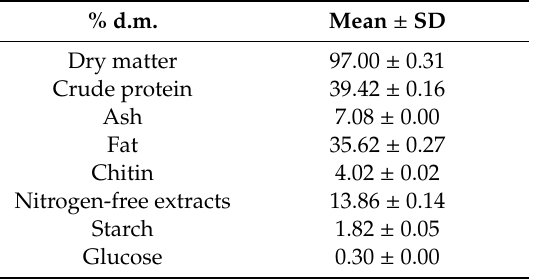
Table 5. Nutritional analyses of the BSF biomass produced on VMD in mass rearing condition.